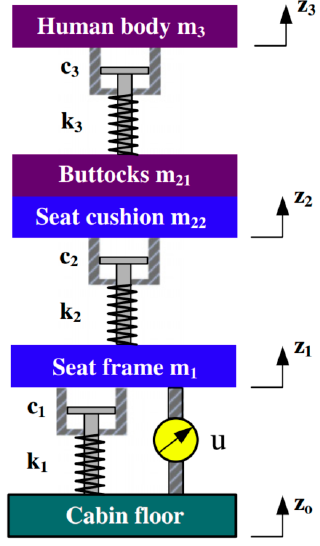
Figure 24. Three-DOF biodynamic model [71].